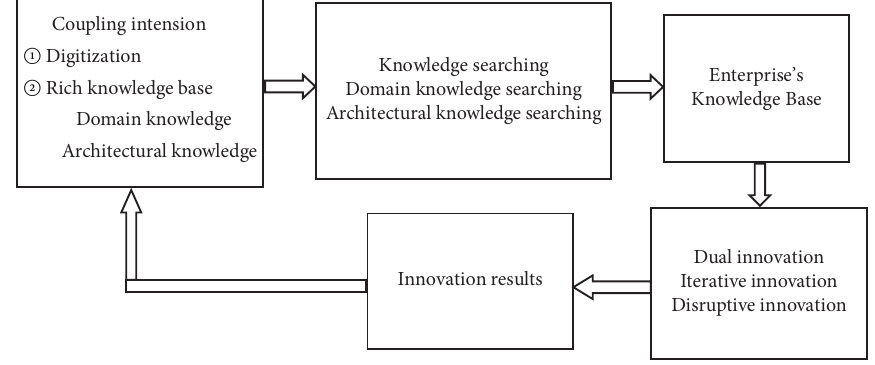
Figure 1: The conceptual